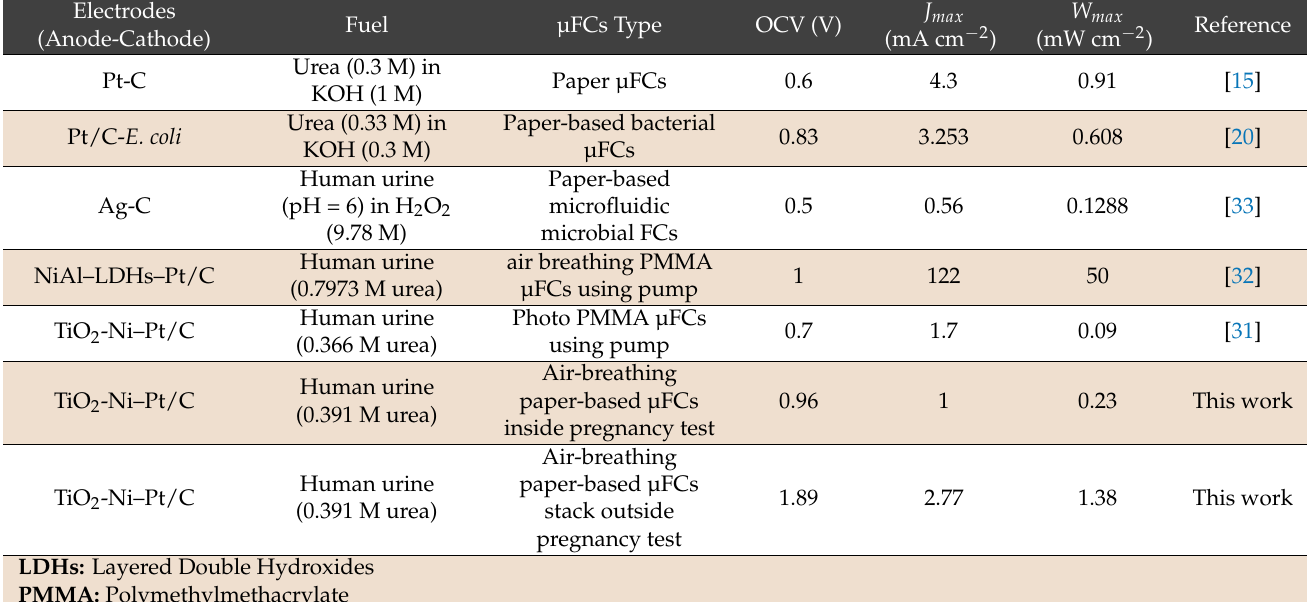
Table 1. Performance parameters of urea or urine microfluidic fuel cells reported in the